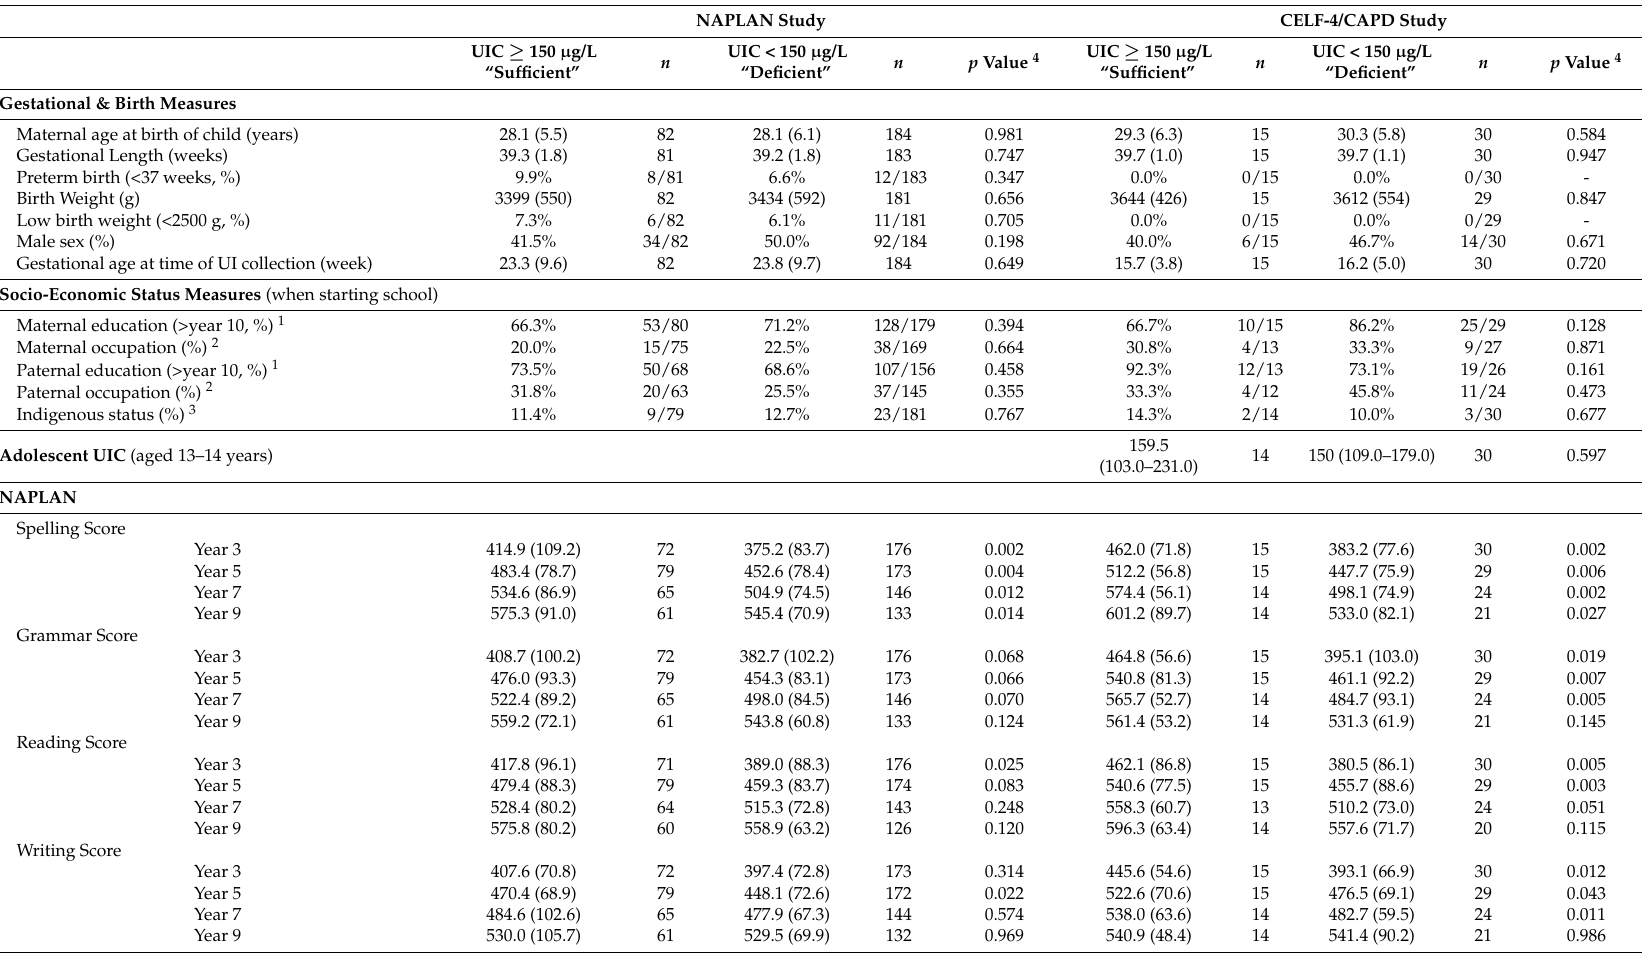
Table 2. Characteristics of participants by maternal UIC during pregnancy ( ≥ 150 vs. <150 µ g/L): data for children in NAPLAN study ( n = 266) and CELF-4/CAPD study ( n =